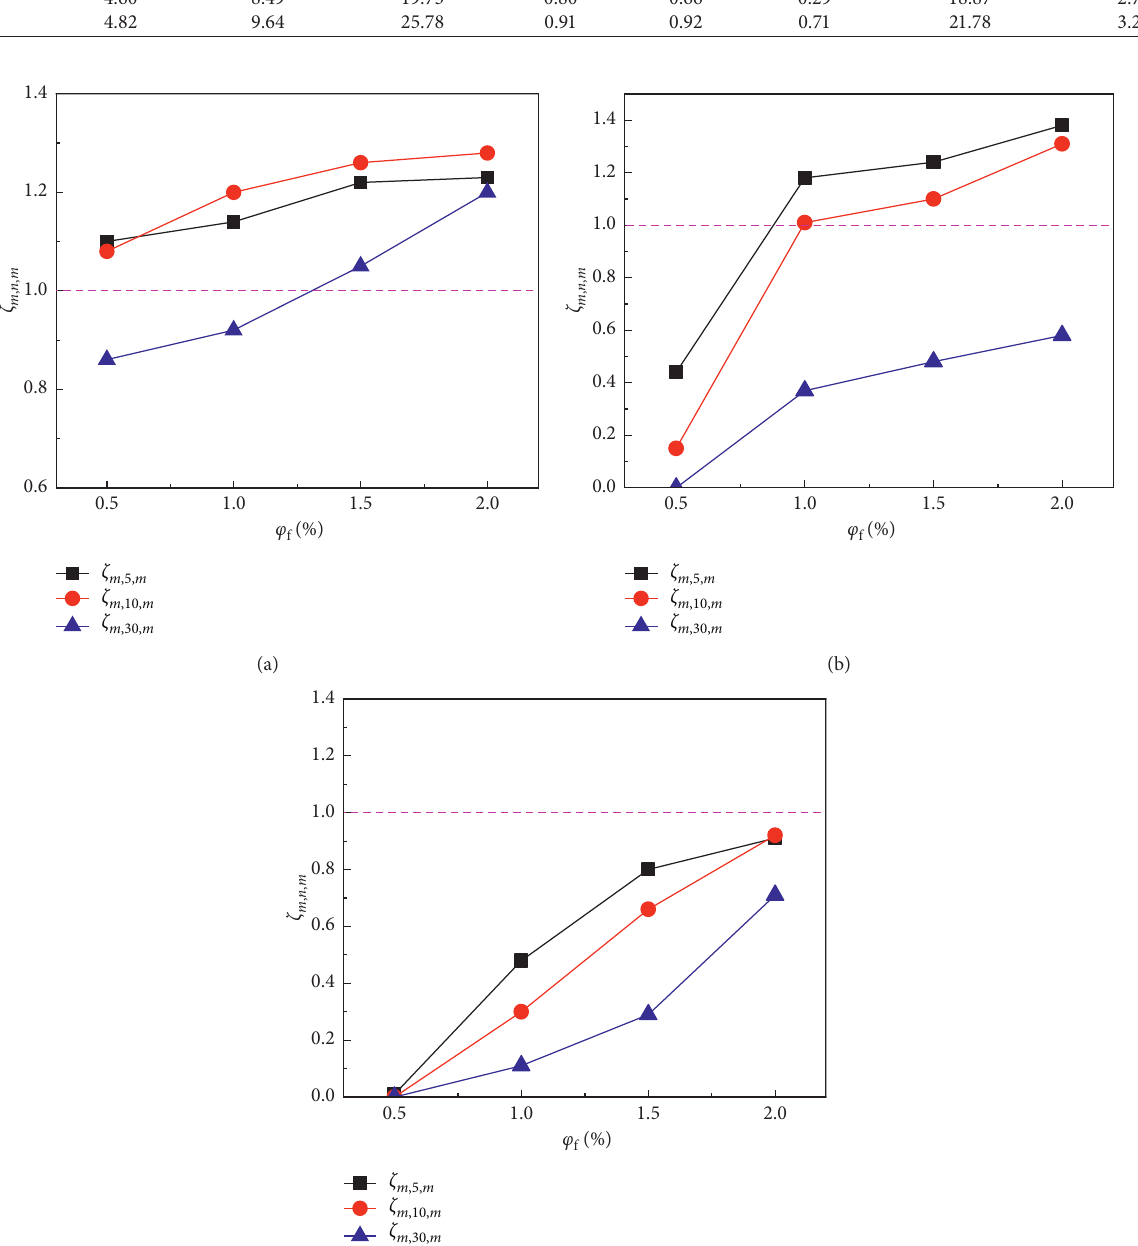
Figure 6: Relationship between the variation factor of flexural resistance and volume ratio of steel fibers. (a) M steel fibers. (b) H steel fibers. (c) C steel